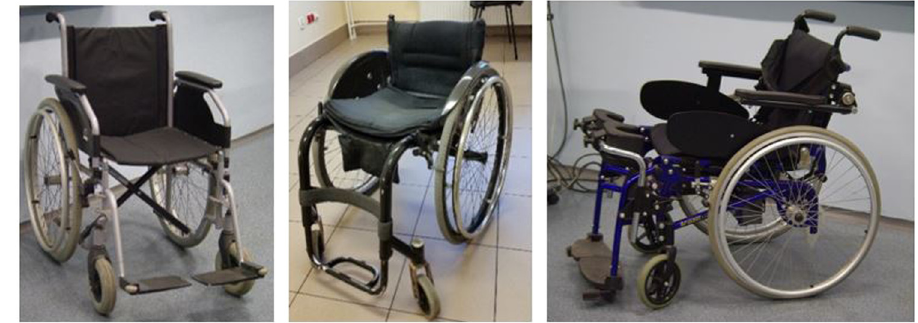
Figure 3: The wheelchairs used in the tests: ( a ) universal, ( b ) active, and ( c ) universal with the user upright